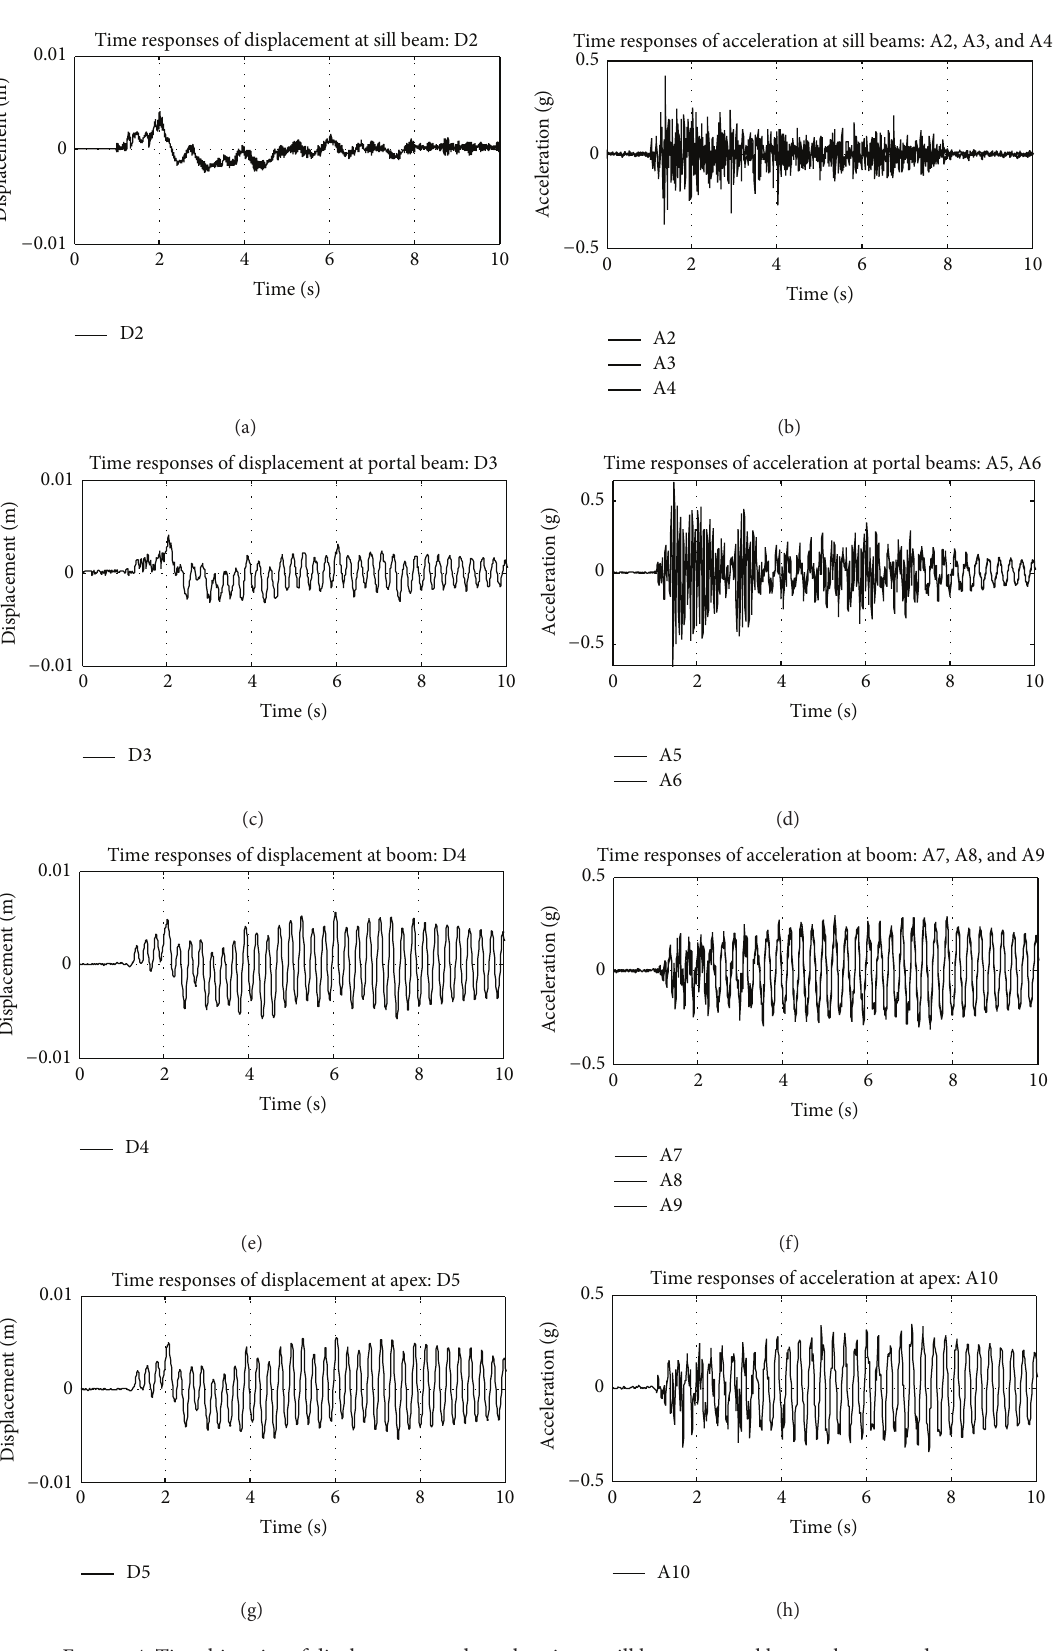
Figure 4: Time histories of displacement and acceleration at sill beams, portal beams, boom, and